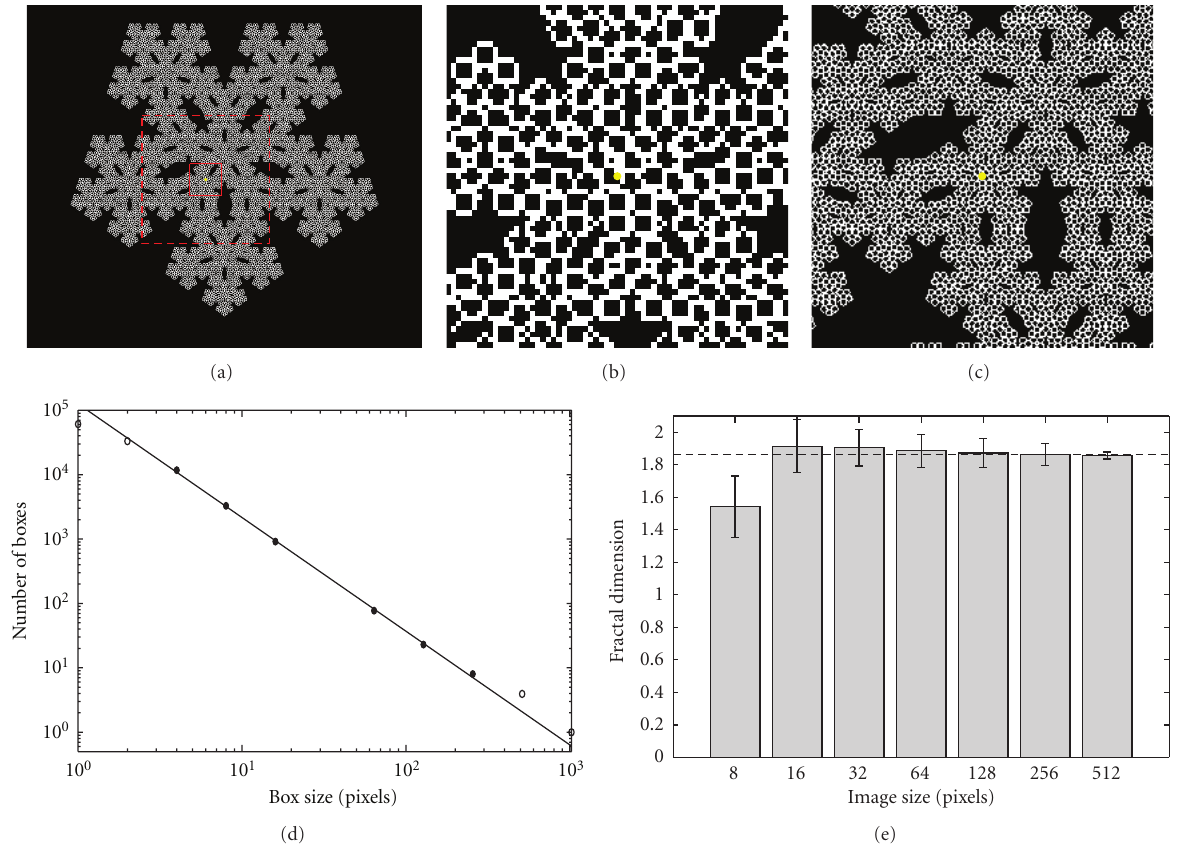
Figure 3: (a) Fifth iteration of a pentaflake. Cropped pentaflake for a size of (b) 64 × 64 (solid square in (a)) and (c) 256 × 256 (dashed square in (a)) pixels. (d) Box size versus the number of boxes. (e) Mean and standard deviation obtained from images of di ff erent